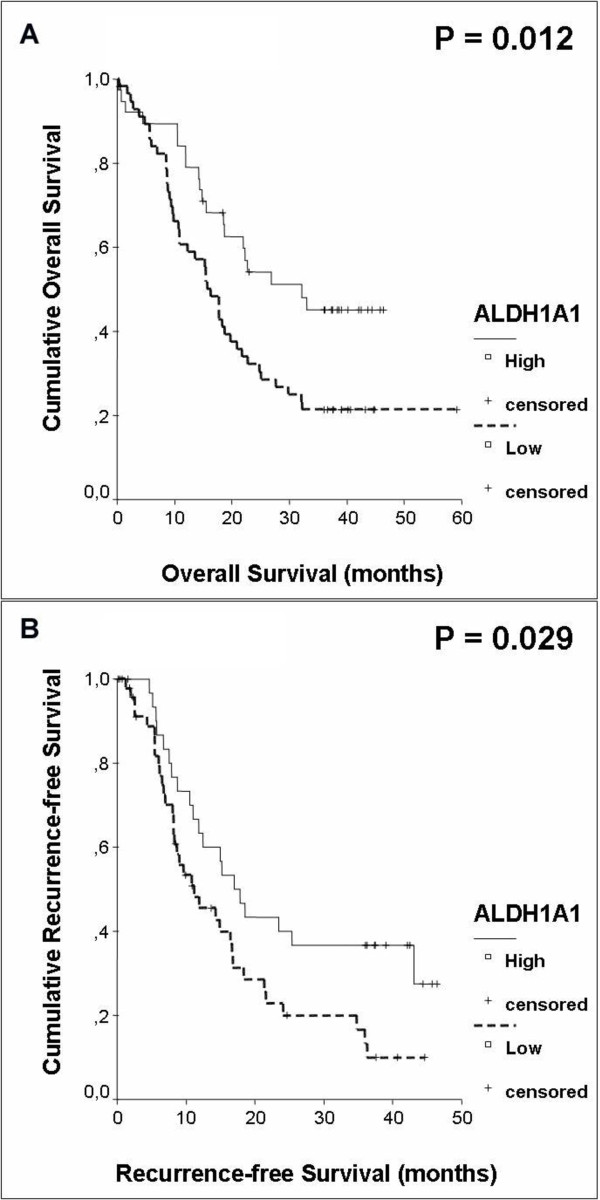
Kaplan-Meier curves displaying (A) median overall survival and (B) median recurrence-free survival in 97 patients with pancreatic cancer and ALDH1negative/low or ALDH1high expression.